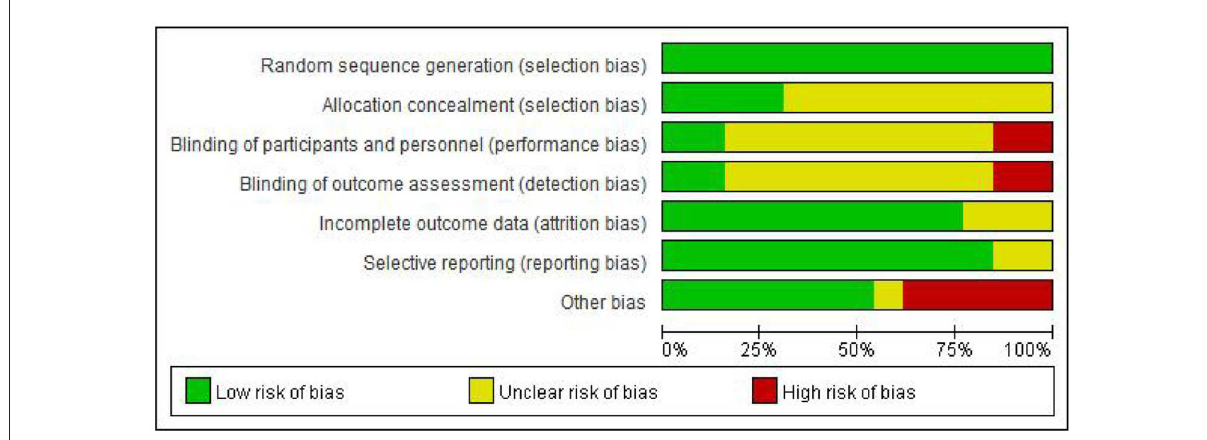
FIGURE2 Risk of randomized control studies bias graph.